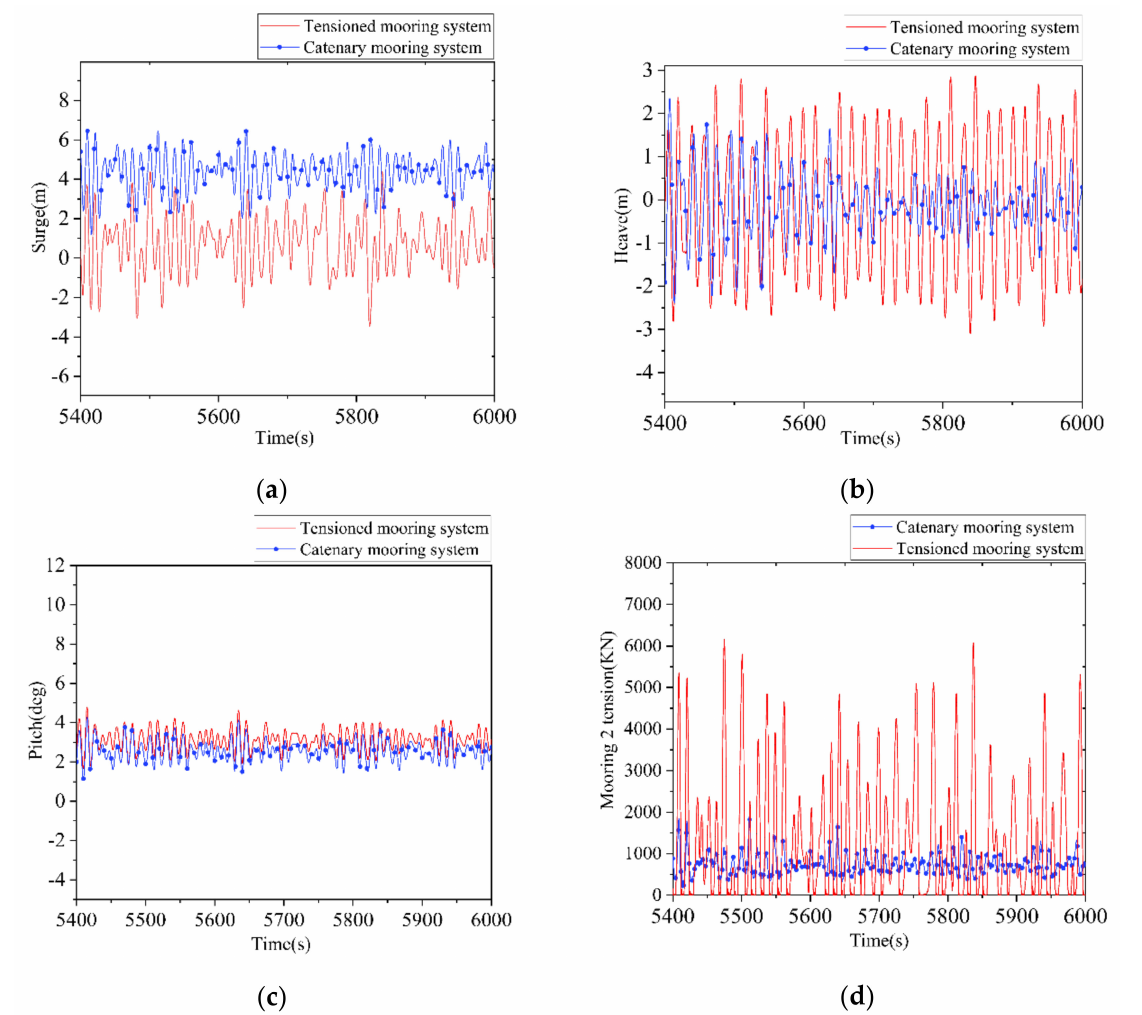
Figure 5. Motion response and tension comparison of floating wind turbine. ( a ) Surge. ( b ) Heave. ( c ) Pitch. ( d )